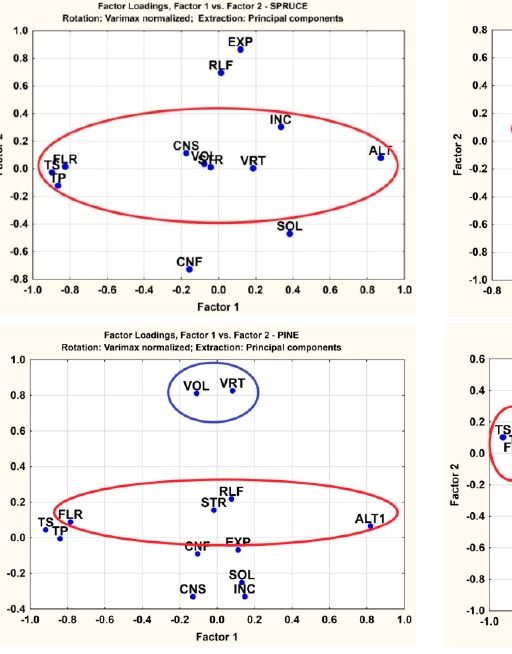
Figure 9. FA diagram for factors 1 and 2.